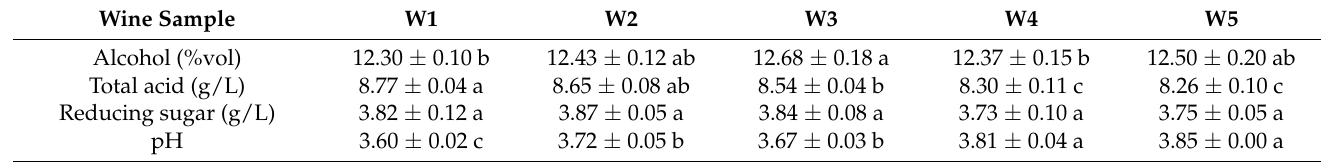
Table 3. Enological parameters of black chokeberry